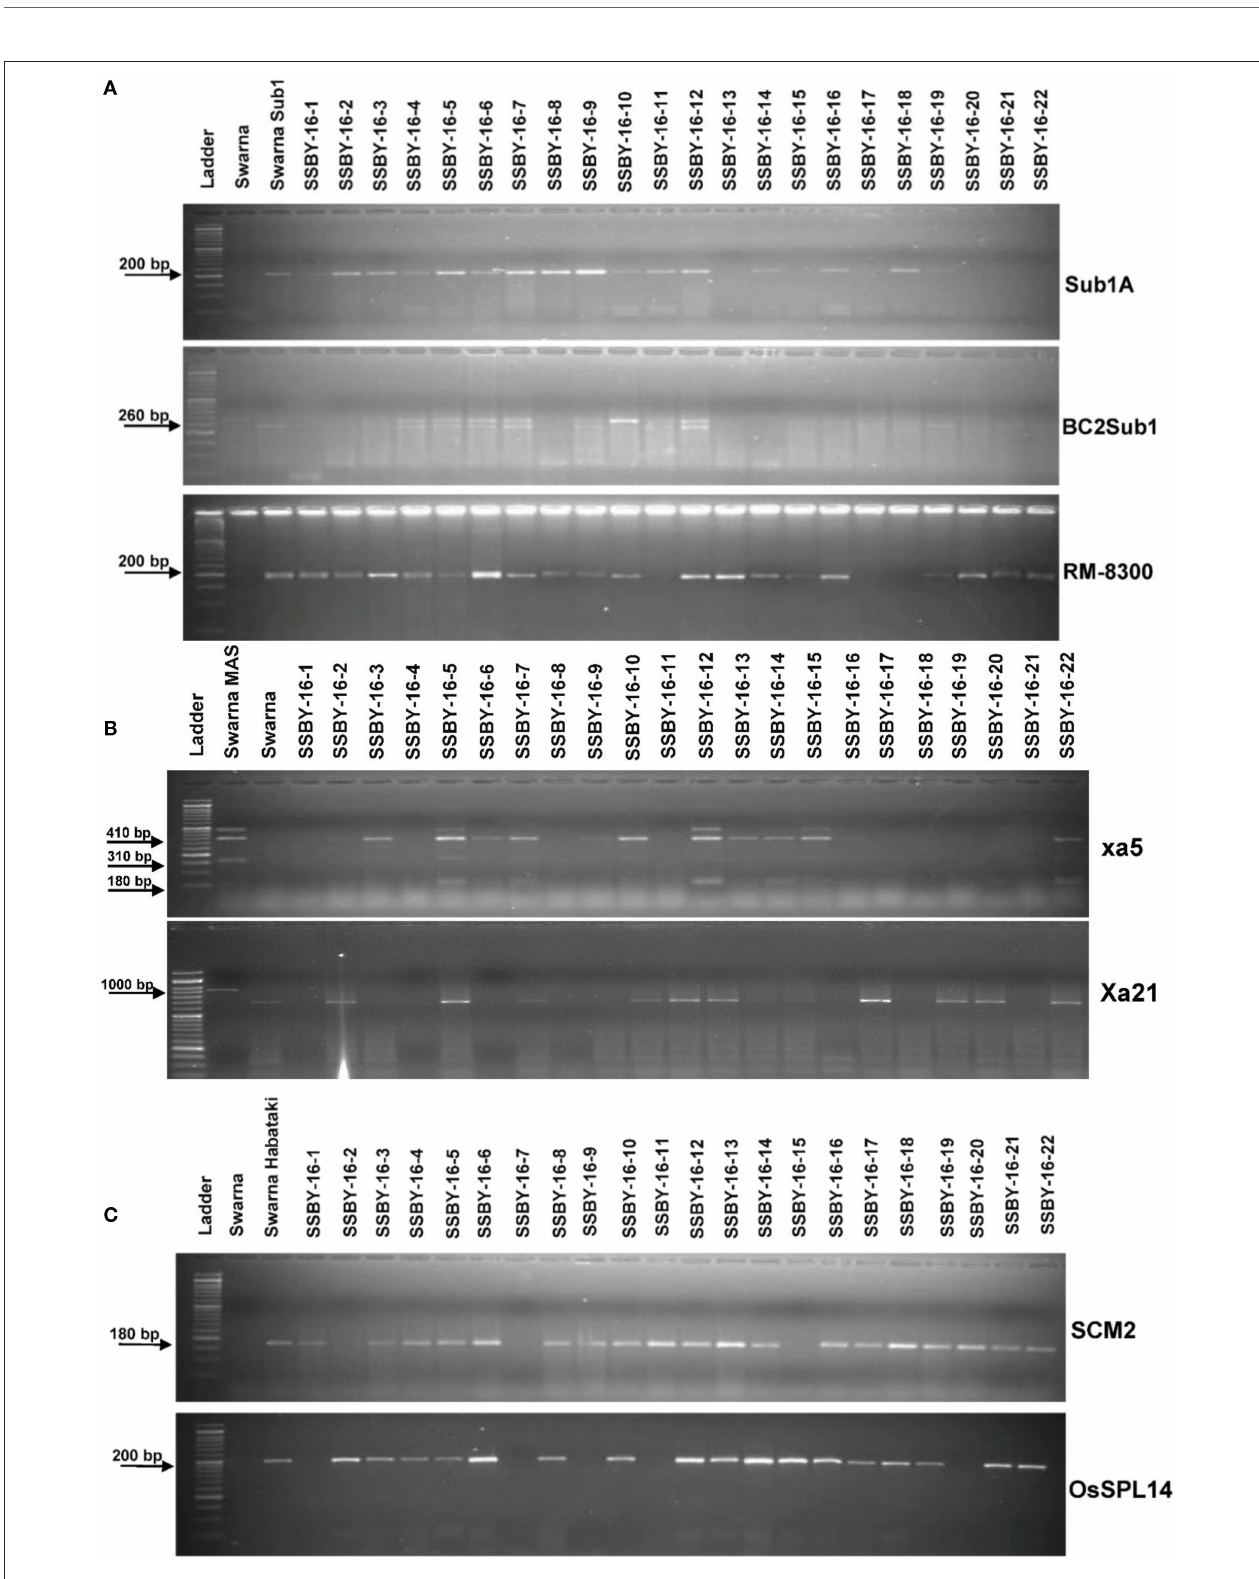
FIGURE 3 | Representative electropherogram of BC 2 F 1 progenies in the Swarna background for (A) submergence tolerance using Sub1A203, BC2Sub1, and RM8300 (B) bacterial blight resistance xa5 and Xa21 and (C) yield component QTLs for OsSPL14 and SCM2 . The designations on the top of the lane indicate the genotypes, and the L is 100 bp DNA ladder. The desired base pair of the markers are written on the left.